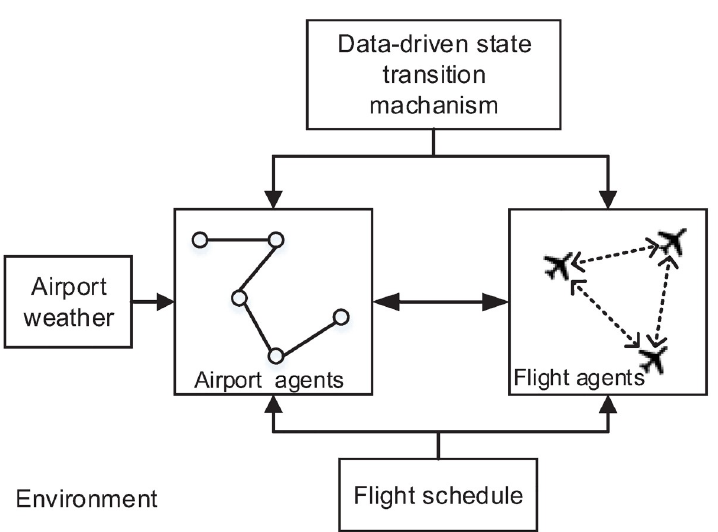
Fig 1. The architecture of the agent-based flight delay prediction